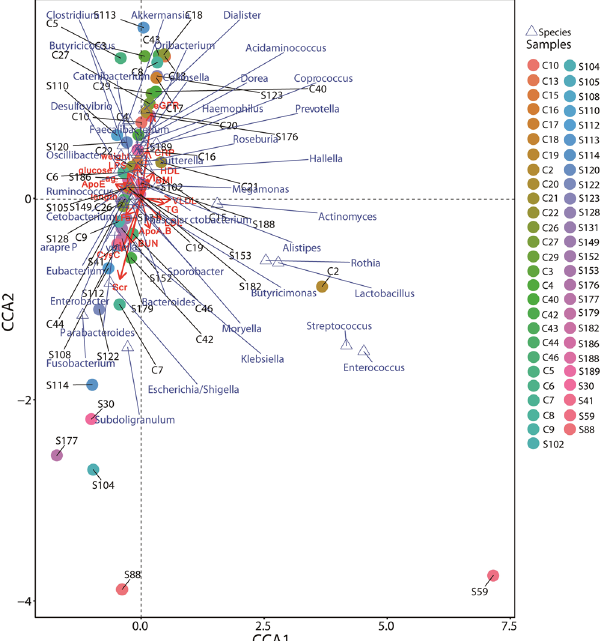
Figure 4. Canonical Correspondence Analysis (CCA) illustrating relations between bacteria taxa and internal environmental parameters accumulated in healthy controls and patients with ESRD in China. Arrows indicate the direction and magnitude of internal environmental parameters associated with bacterial community structure. The explained variance of the principal axes [Axis 1 (horizontally) and Axis 2 (vertically)] are 9.319% and 6.008%, respectively; The species explained 39.82% of the total information amount. The filled circle represents samples, triangle represents species. S * and C * represent ESRD patients and healthy controls